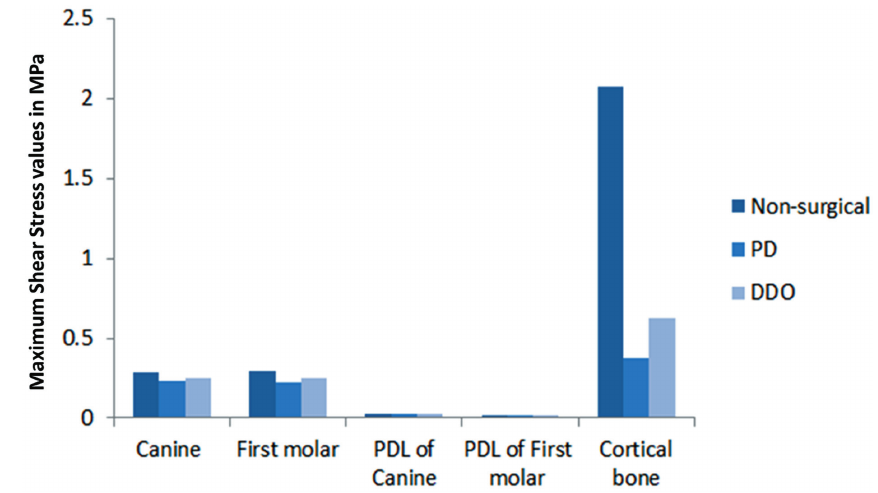
Figure 9- Maximum shear stress values induced in different parts of three models. PDL= periodontal